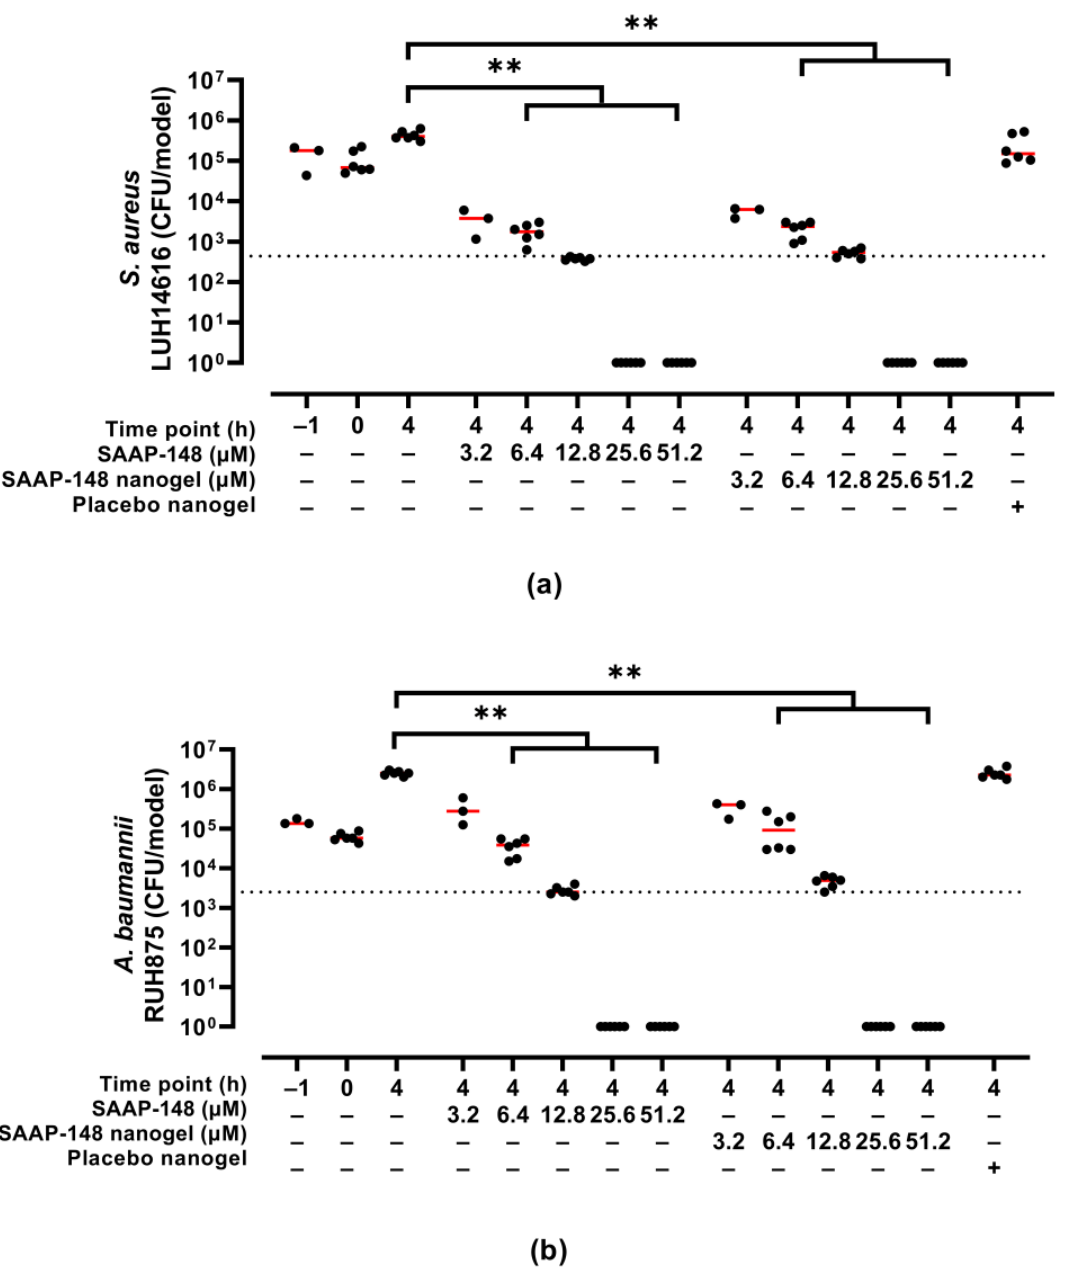
Figure 3. Bactericidal effects of redispersed PVA-lyophilized SAAP-148-loaded nanogels to colonized 3D human epidermal models compared to SAAP-148 and placebo nanogels. The 3D human epidermal model was infected for 1 h with AMR ( a ) S. aureus or ( b ) A. baumannii before exposure for 4 h to SAAP-148, SAAP-148 nanogel or placebo nanogel. The amount of placebo nanogel was equal to that of the highest dose of SAAP-148 nanogel. Data are shown as median and individual values of three experiments performed in singlicate or duplicate. Statistical differences between two groups are depicted as ** for p ≤ 0.01. The dashed line indicates the LC 99.9 , i.e., the lowest SAAP-148 concentration required to eradicate 99.9% of the bacteria colonizing the model.